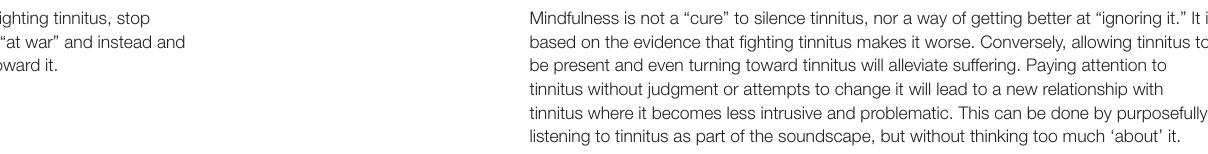
TABLE 2 | Clinical suggestions for applying mindfulness to tinnitus. Stop fighting tinnitus, stop being “at war” and instead and turn toward